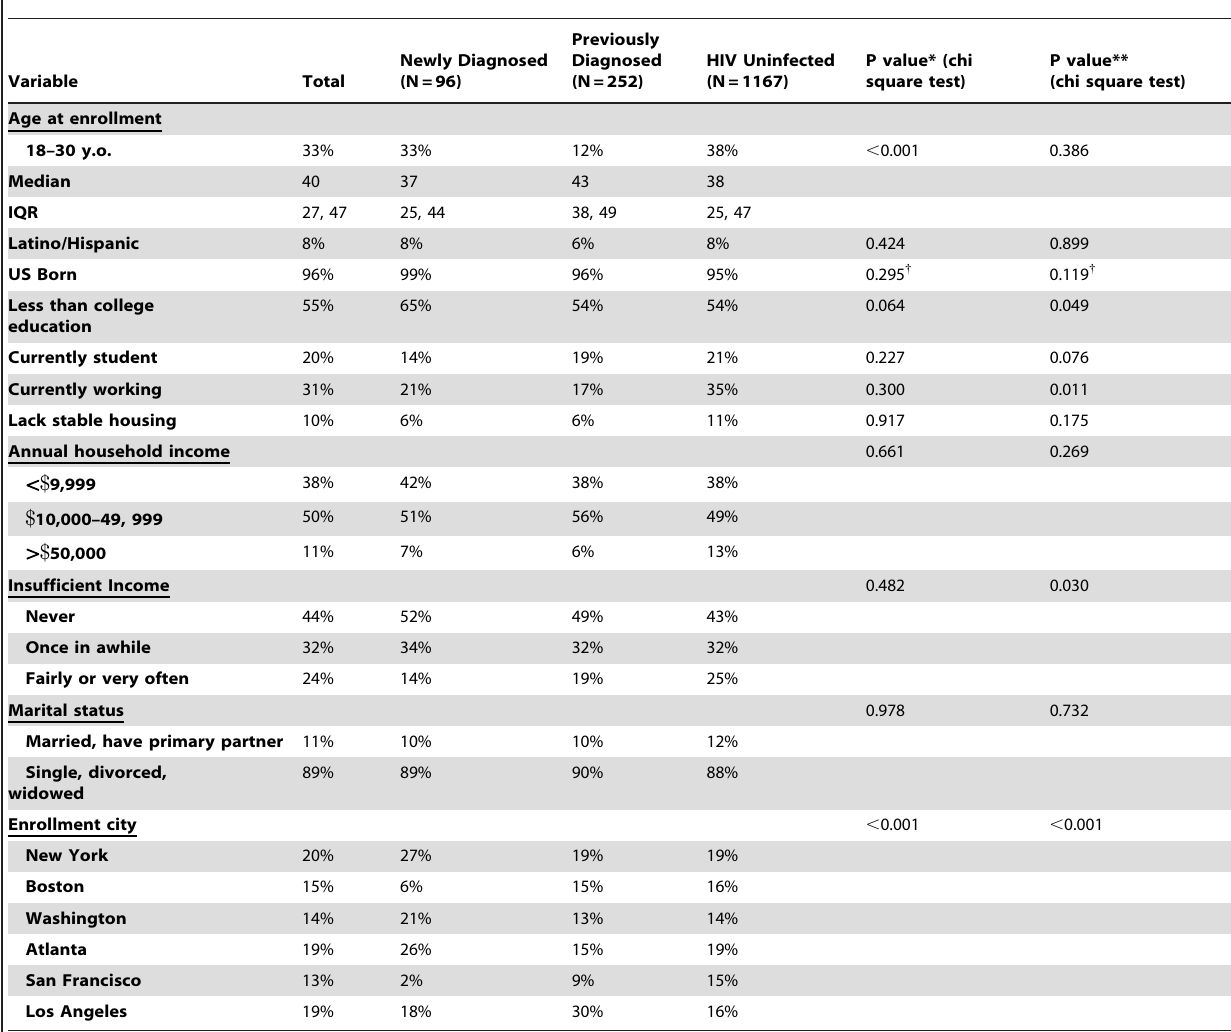
Table 1. Sociodemographic characteristics of HPTN 061study participants by HIV status: Newly diagnosed versus previously diagnosed or